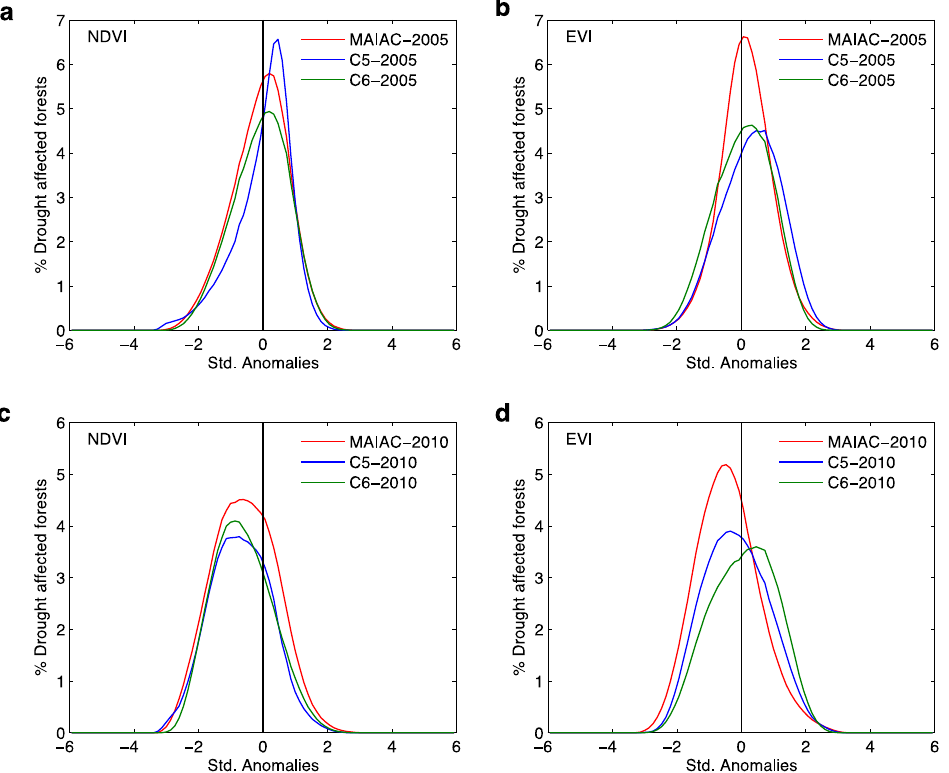
Figure 5. Histograms of remotely sensed greenness standardized anomalies over drought impacted Amazon forests in 2005 and 2010. ( a ) Histograms of NDVI standardized anomalies in 2005; ( b ) Histograms of EVI standardized anomalies in 2005; ( c ) Histograms of NDVI standardized anomalies in 2010; ( d ) Histograms of EVI standardized anomalies in 2010.